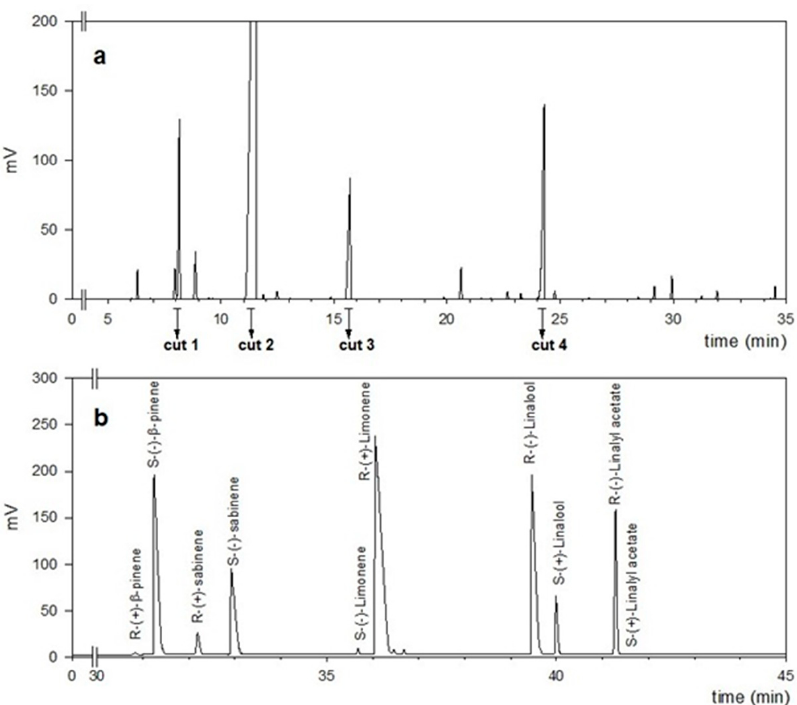
Figure 4. Analysis of the chirality of Neapolitan limmo and lemoncetta Locrese ( a ) GC chromatogram of Neapolitan limmo essential oil with the four heart-cuts. ( b ) Enantio-MDGC chromatogram of selected chiral compounds in Neapolitan limmo.